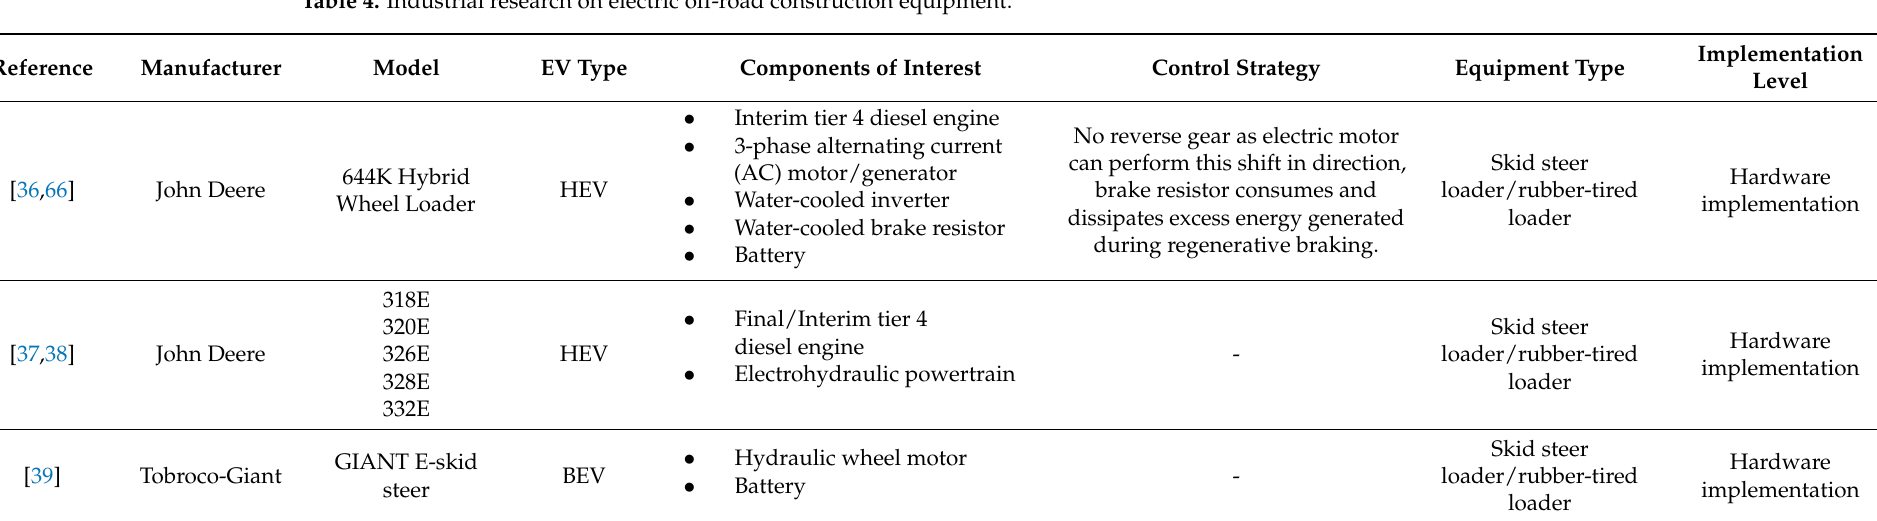
Table 4. Industrial research on electric off-road construction